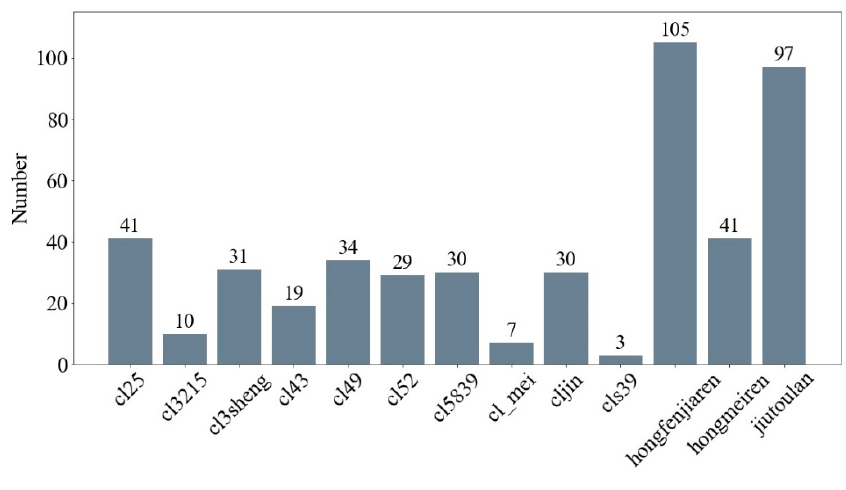
Figure 5. The number of each orchid.